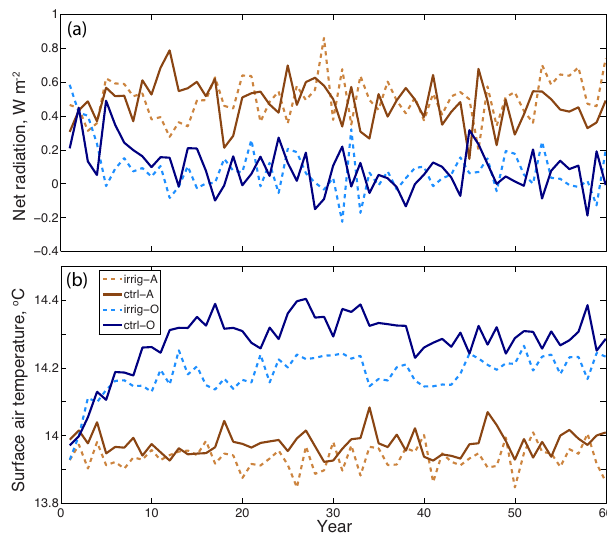
Figure 2. Global and annual mean (a) top-of-atmosphere net radi- ation and (b) surface air temperature over the four